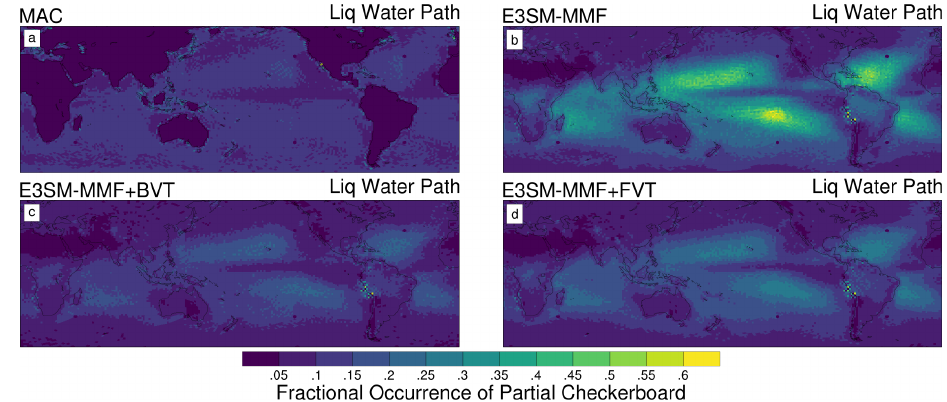
Figure 4. Maps of fractional occurrence of partial checkerboard patterns (see text) on the ne30pg2 grid for MAC-LWP (a) , E3SM-MMF (b) , E3SM-MMF with bulk variance transport (BVT, c ), and E3SM-MMF with filtered variance transport (FVT, d ).